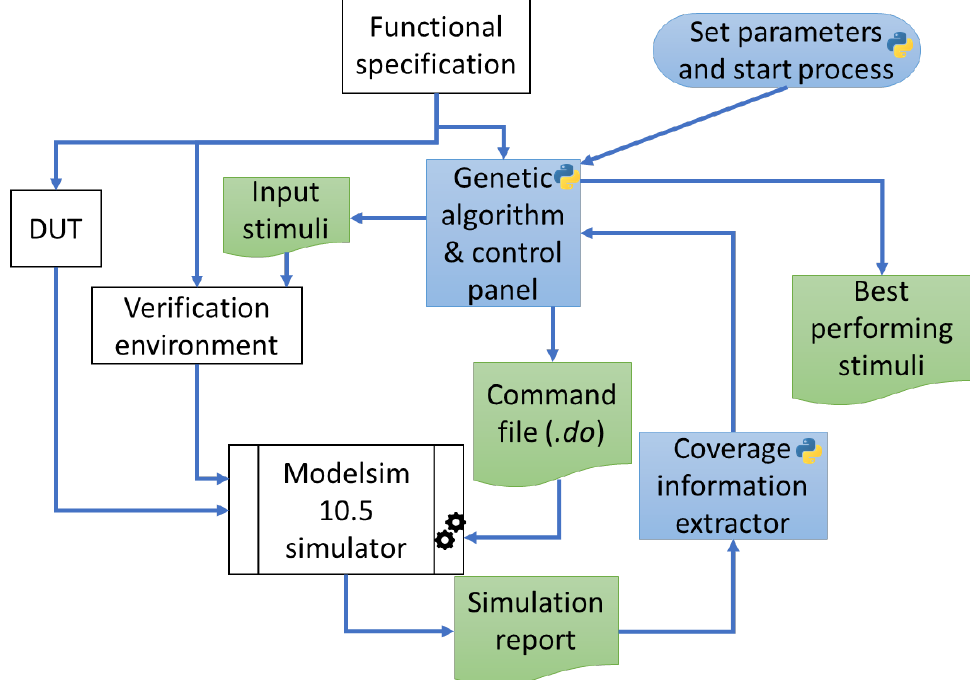
Figure 8. Information processing flow developed in the current research. The blue boxes represent modules written in Python, the green shapes represent text files generated during system operation, and the white boxes are items that are used during the classical verification process. Genetic algorithms tune the verification process by adding a layer of automatic control to the classical verification